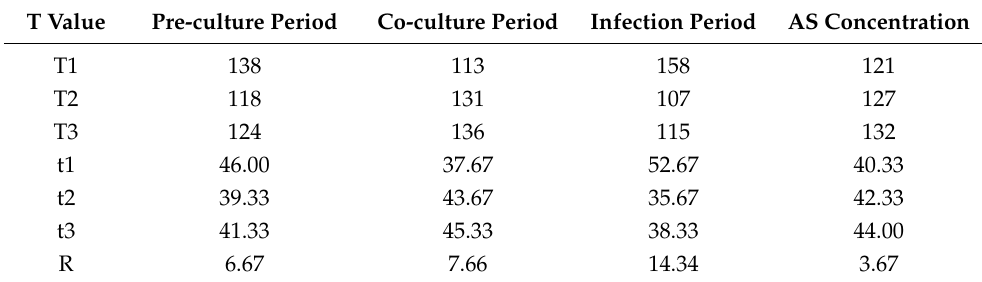
Table 6. Statistics analysis of the intersubjective